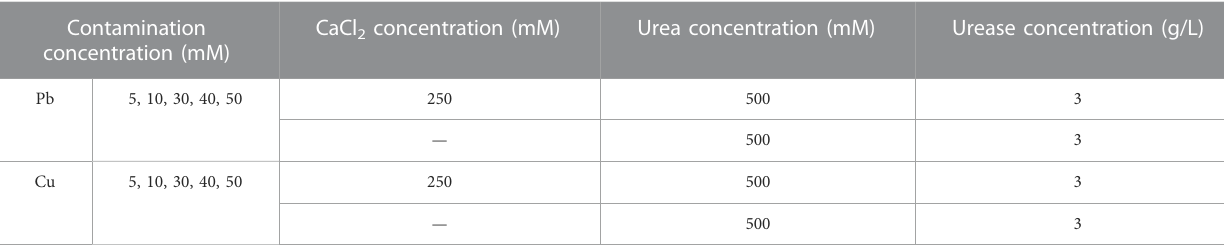
TABLE 2 Testing scheme applied to Pb and Cu remediation using EICP.